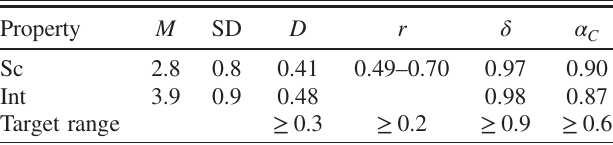
TABLE III. Characteristics of the interest or self-concept test (pretest). Mean ( M ), standard deviation (SD), discrimination index ( D ), item-test-correlation ( r ), Ferguson ’ s delta ( δ ), Cron- bach ’ s alpha ( α ) [134]; target range according to Ding and C Beichner [134] and EPFA [133]. TABLE IV. Characteristics of the learning test (post-test values). Solution probability ( P ), discrimination index ( D ),